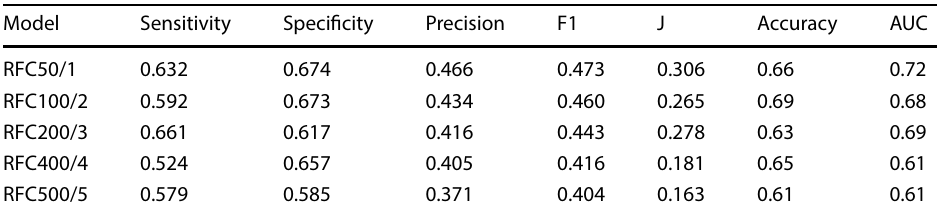
Table 6 RFC performance with average of 3 classes